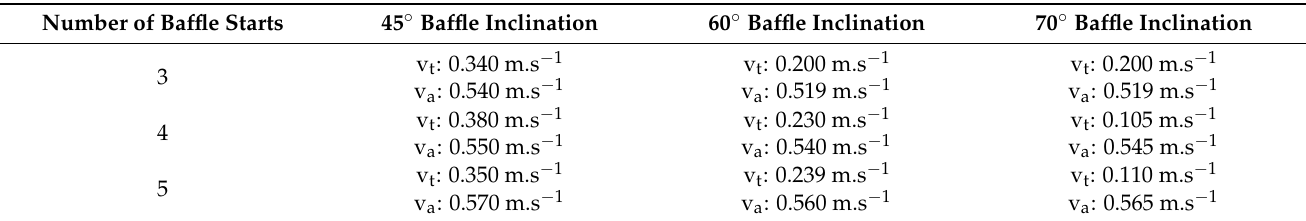
Table 2. Maximum axial and tangential velocities in tested configurations as modelled in COMSOL.